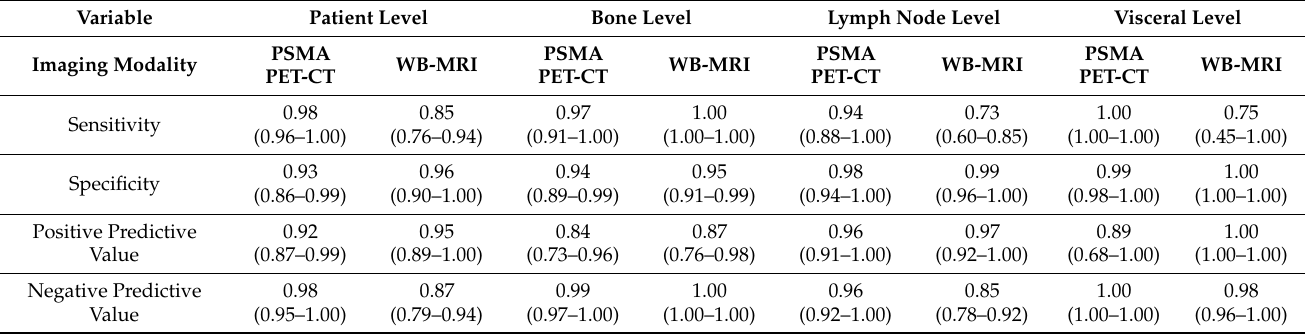
Table 2. Comparison of the diagnostic effectiveness of PSMA PET-CT and WB-MRI in 134 patients with prostate cancer (at the organ and patient